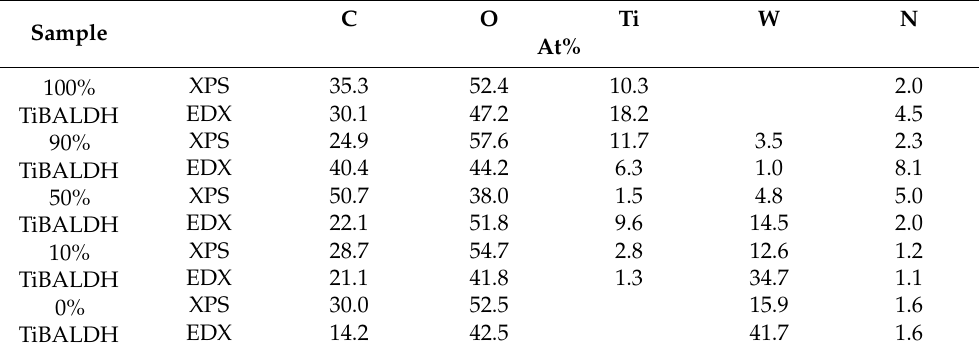
Table 1. Elemental composition of the annealed fibers based on XPS and energy-dispersive X-ray (EDX).